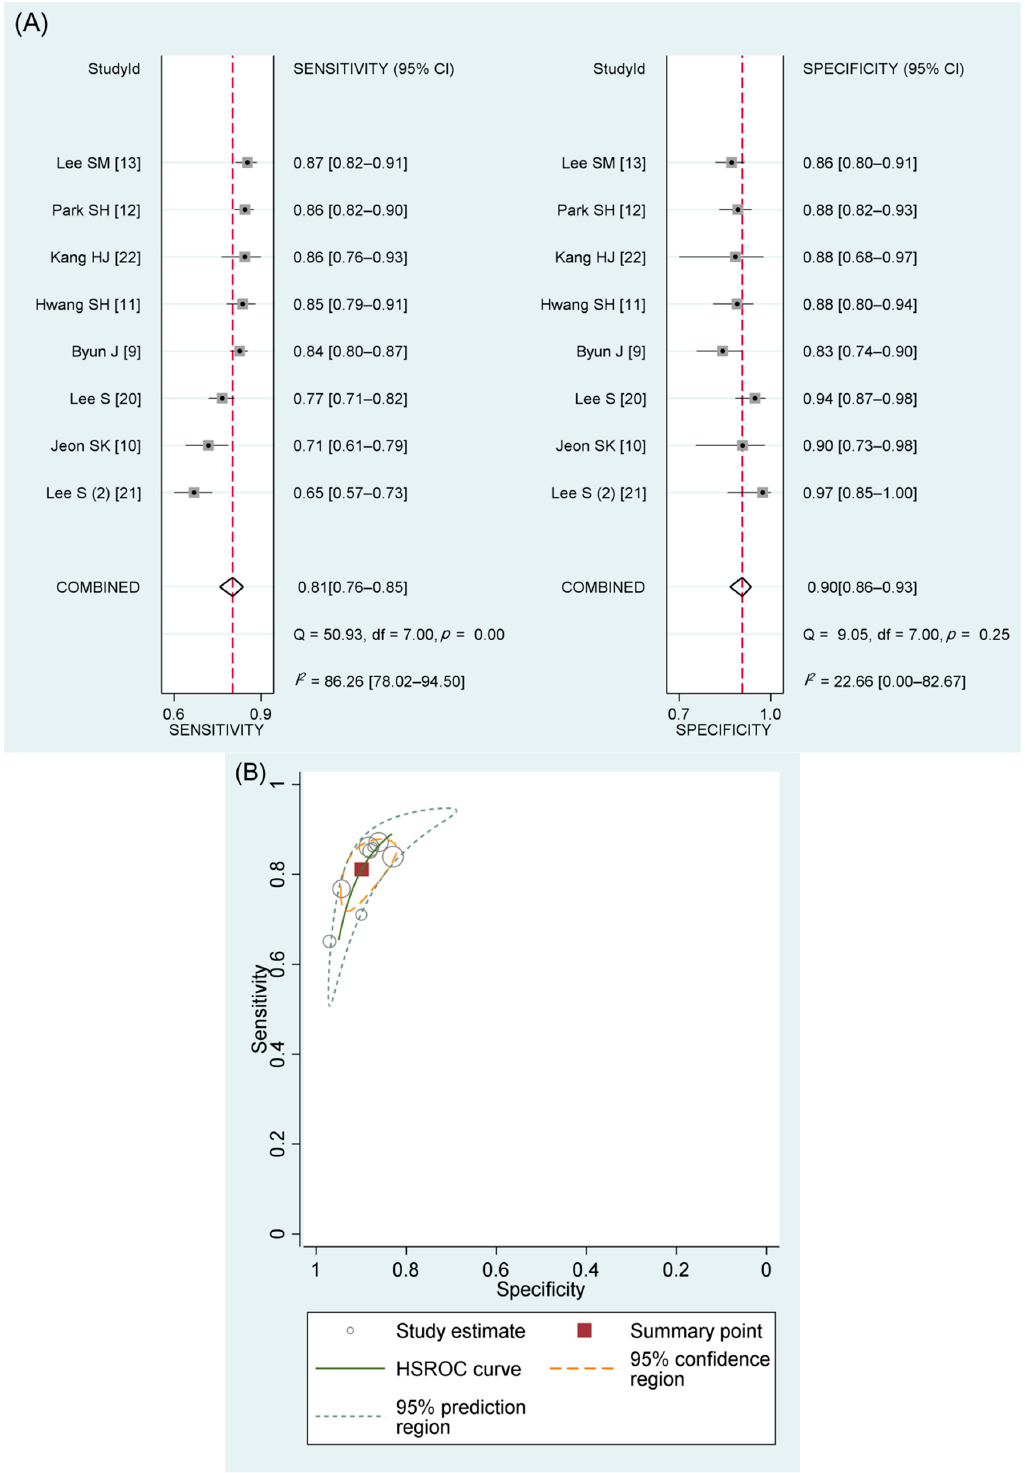
Figure 2. Coupled forest plots and HSROC curve for definite HCC of KLCA-NCC 2018 imaging criteria. ( A ) Coupled forest plots of the sensitivity and specificity of definite HCC for the diagnosis of HCC. ( B ) HSROC curve for the accuracy of definite HCC for the diagnosis of HCC. HSROC, hierarchical summary receiver operating characteristic; HCC, hepatocellular carcinoma; KLCA-NCC, Korean Liver Cancer Association-National Cancer Center; CI, confidence interval; df, degrees of freedom.